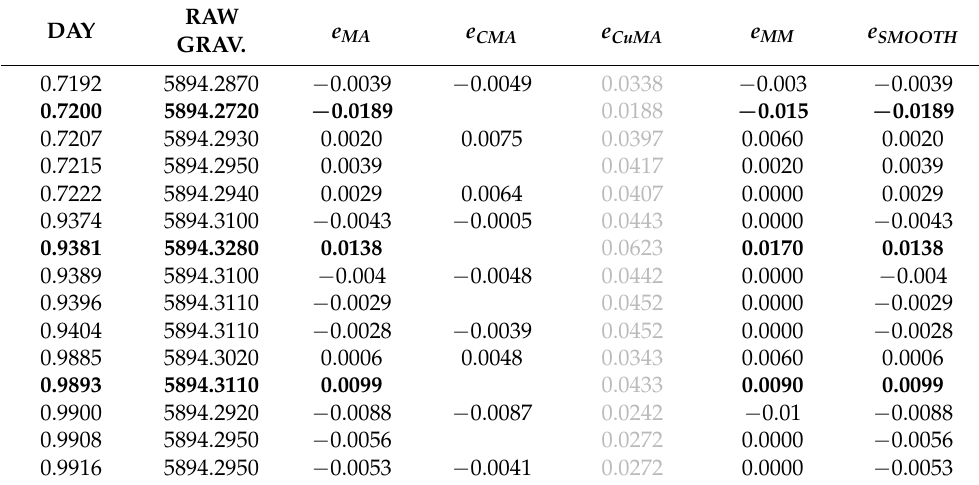
Table 2. An overview of the particular residuals estimated at critical points in the time